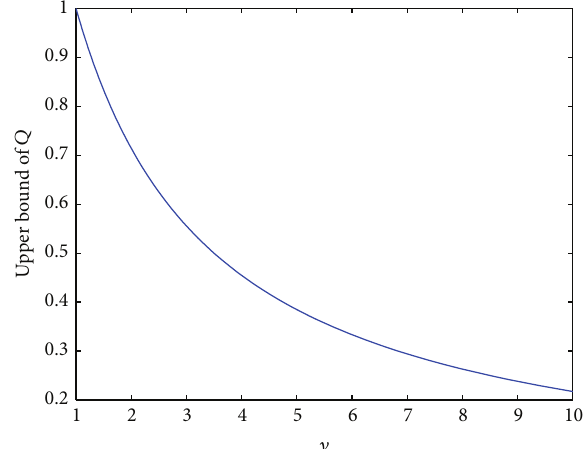
Figure 5: The bound above which an adding link cannot make the total costs increase under DSO.